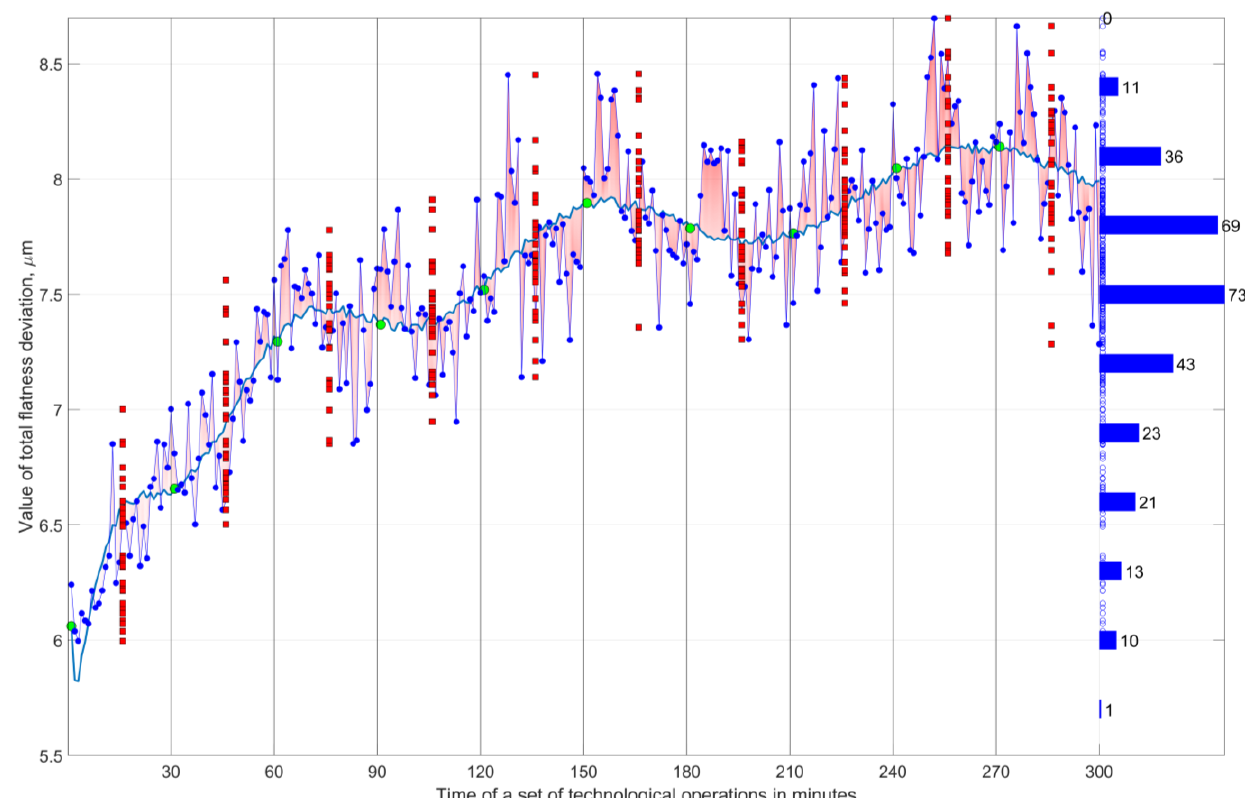
Figure 10. Results of the study of the form of momentary and total flatness deviation distribution of ground small ceramic parts in the automated grinding process using the built AR7 machining system (depicted on Figures 11 and 12) .